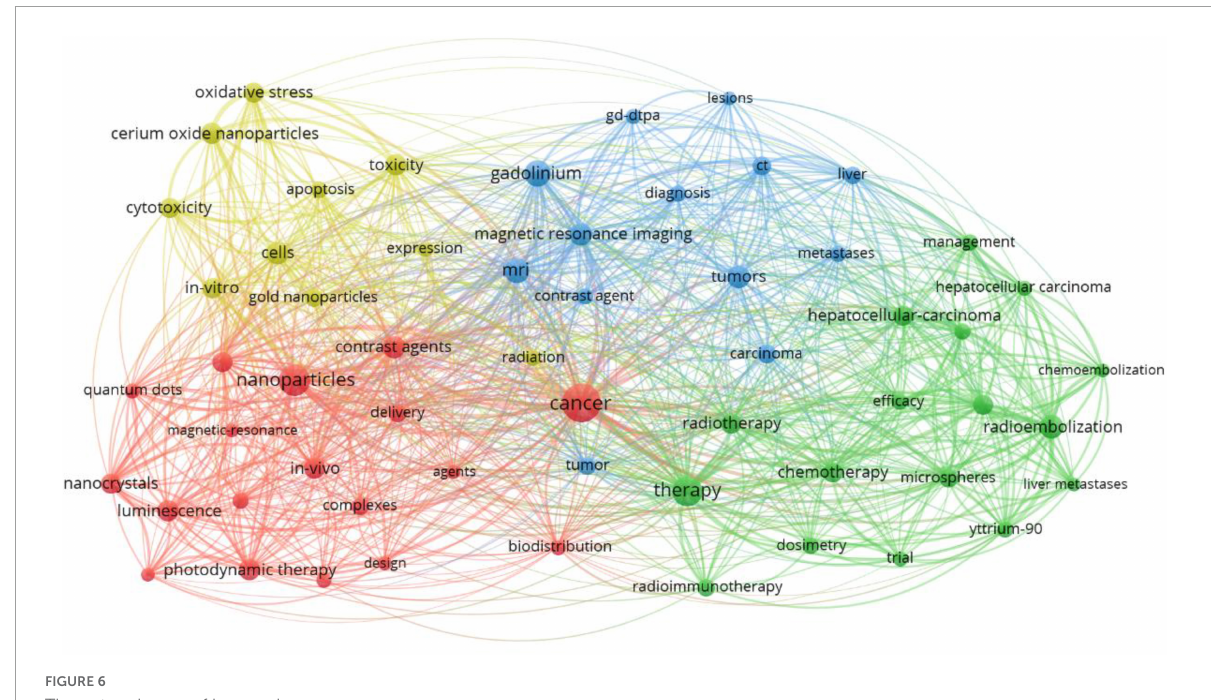
FIGURE6 The network map of